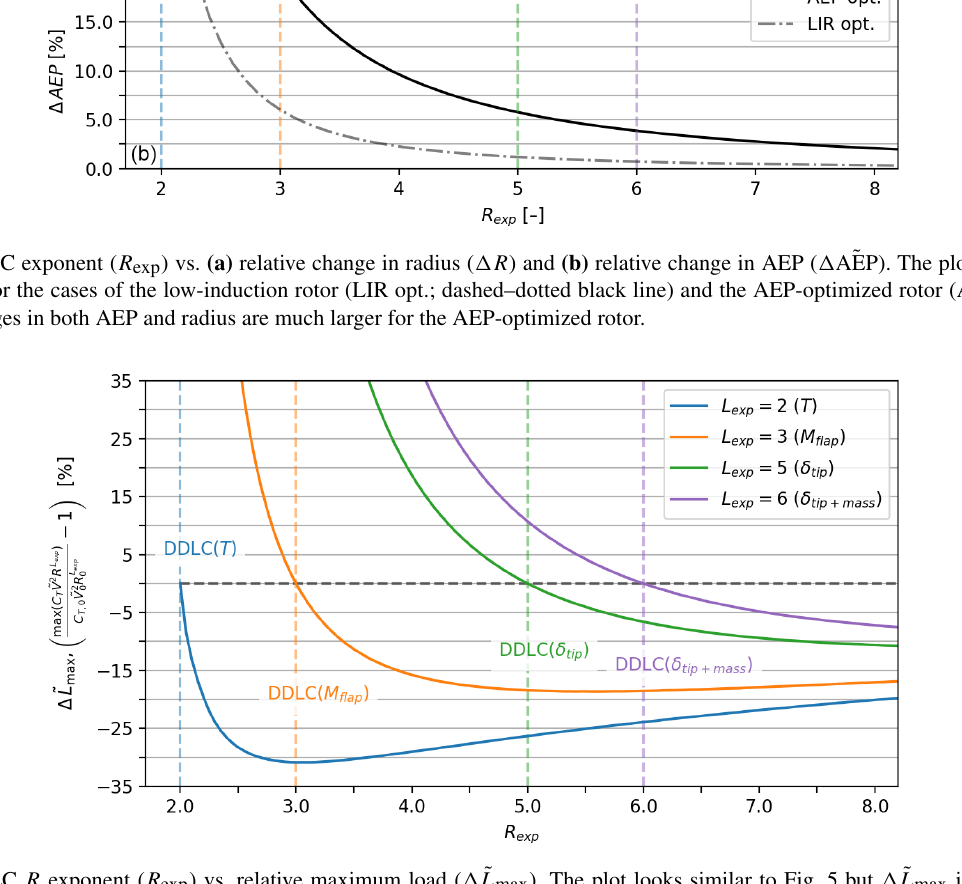
Figure 13. DDLC R exponent ( R exp ) vs. relative maximum load ( (cid:49) ˜ L max ). The plot looks similar to Fig. 5 but (cid:49) ˜ L max is the change in maximum loading. As an example, when thrust ( T ) is − 30 . 8% for R exp = 3 it means that the maximum thrust (for any wind speed) is 30.8% lower than the maximum thrust for the baseline (which happens just before the rated wind speed). Notice that the range for the y scale is much larger in this plot than for the power-capture-optimized rotor. The potential reduction is more, but it comes with the consequence that L exp > R exp grows faster even for high values of R exp